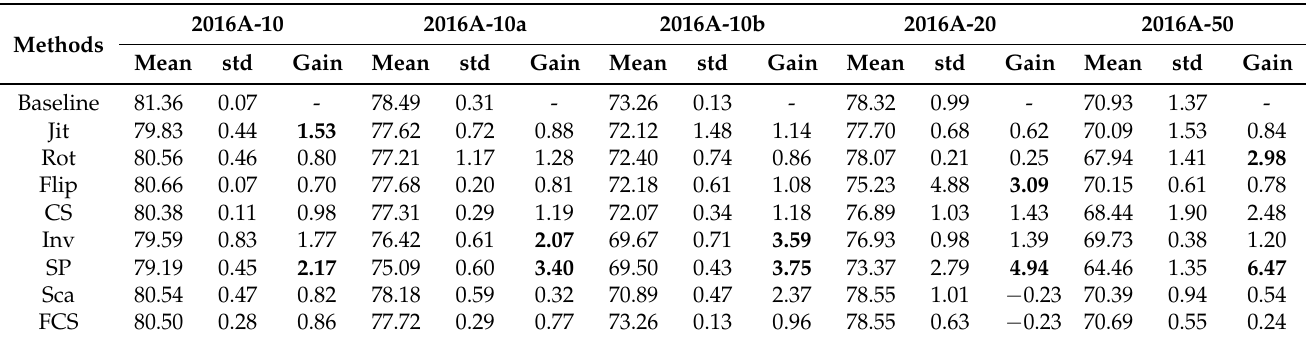
Table 6. The average improvement brought to SigAugment-R by each transformation. In terms of gain, we highlighted the top two